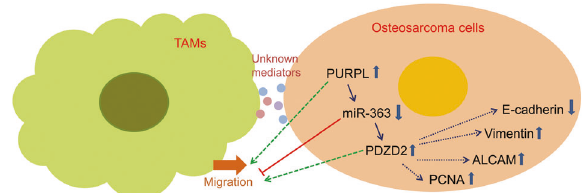
Fig. 7 The interrelation of TAMs and PURPL/miR-363/PDZD2 axis on OS progression. TAMs-promoted OS progression could be through regulating PURPL/miR-363/PDZD2 signaling. PURPL/miR- 363/PDZD2 aix also could feedback modulate TAMs